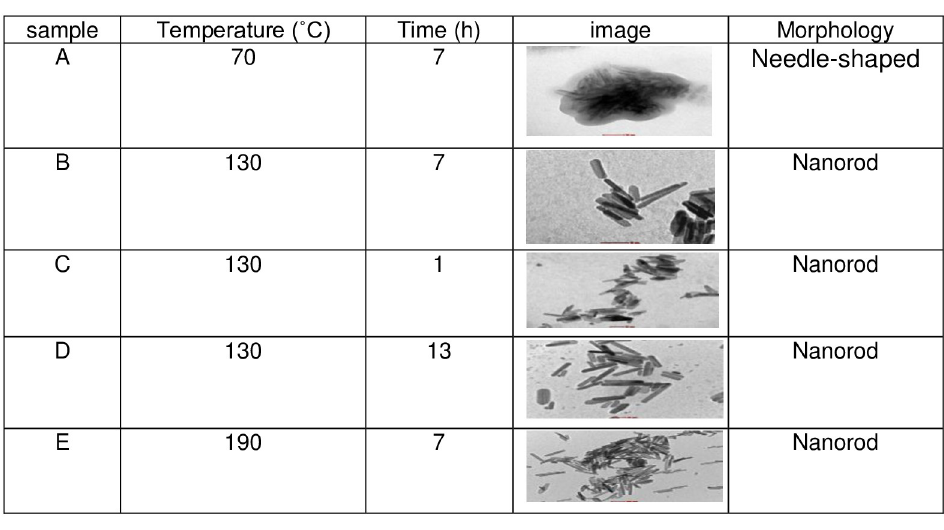
Fig 3. TEM images for HAp samples in normal conditions (pH =